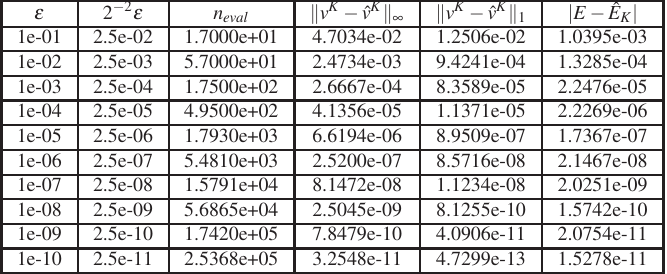
Table 8 Parameters as specified in Table 1 for f 1 , K = 15 and the polygonal rule. ε k = ε varies between 10 − 1 and 10 − 10 .